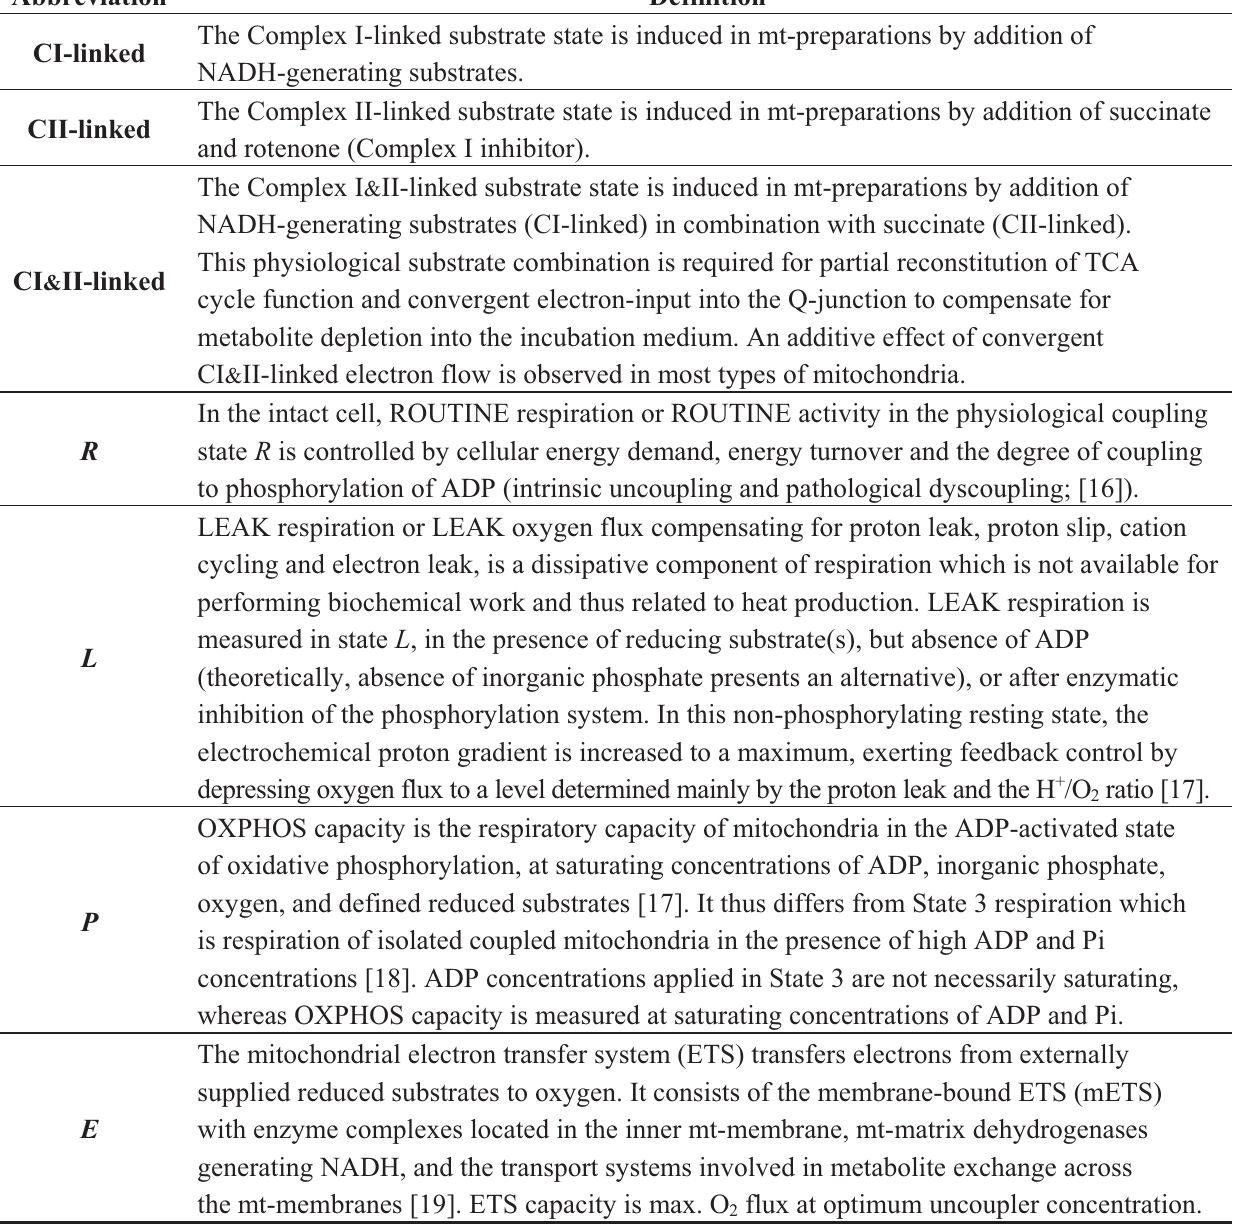
Table 1. Definitions of Substrate States and Coupling States used to Characterize Mitochondrial